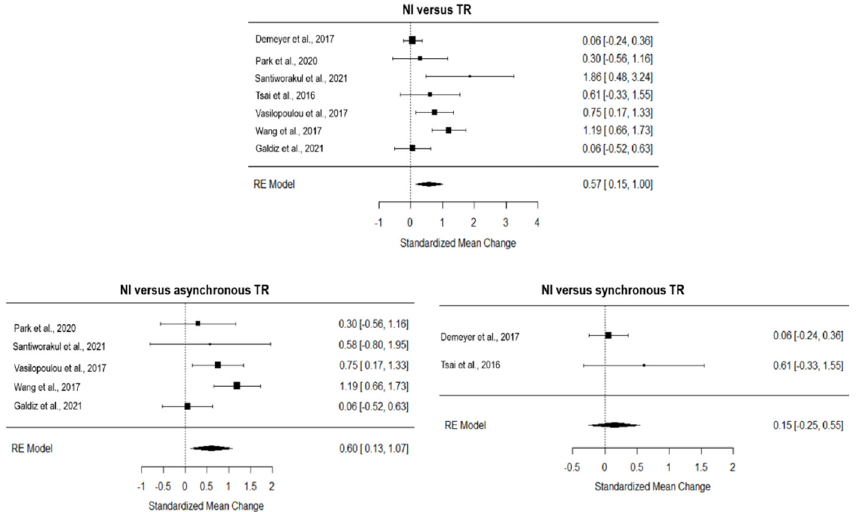
Figure 6. Forest plot of the effect of TR on quality of life compared to usual care. TR, TR; NI, no intervention [8,29,33–35,38,41]. Ref [31] was not included in this analysis based on the leave-one- out analysis.